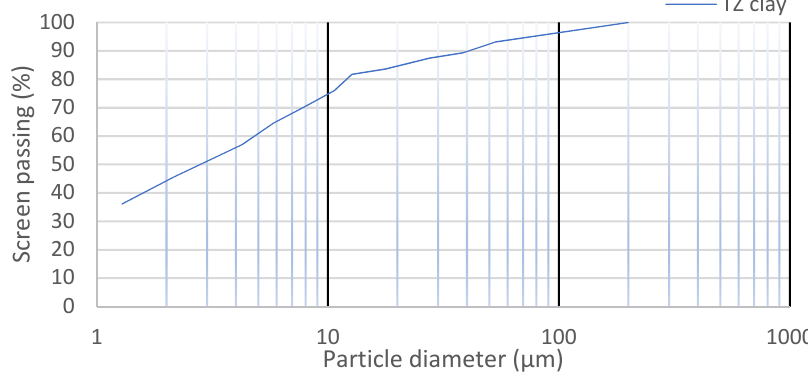
Figure 2. Particle size distribution of TZ clay.